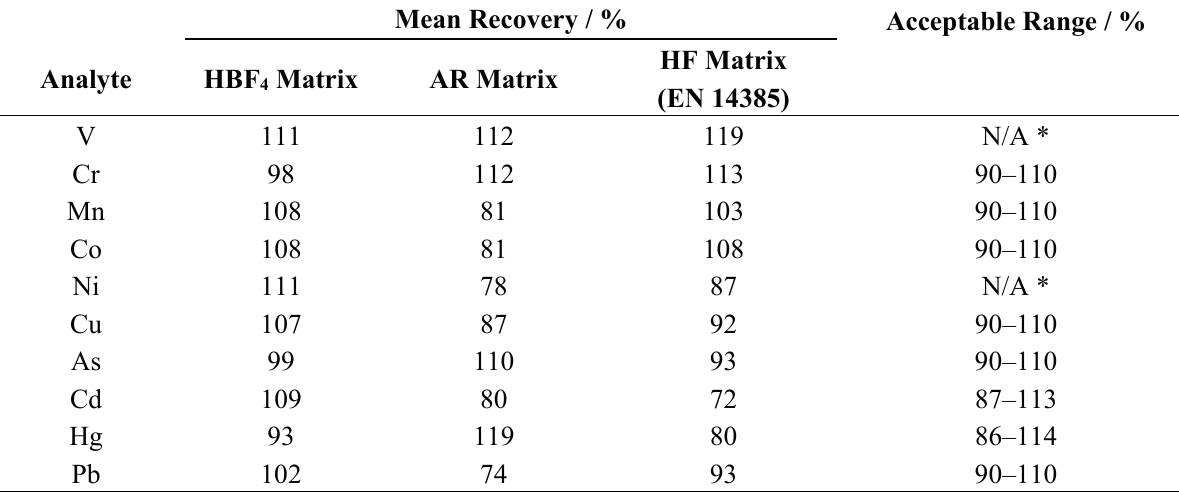
Table 2. Comparison of % recoveries obtained with all three preparation methods from BCR-038. EN 14385 [7] stipulates that measured concentrations shall not differ more than 10% from the certified value or shall be within twice the uncertainty value quoted for the CRM, whichever is larger (* V and Ni acceptable ranges are shown as ‘N/A’ because BCR-038 gives indicative values only for these elements). In the UK, MID 14385 [8] allows for recoveries 100% ±